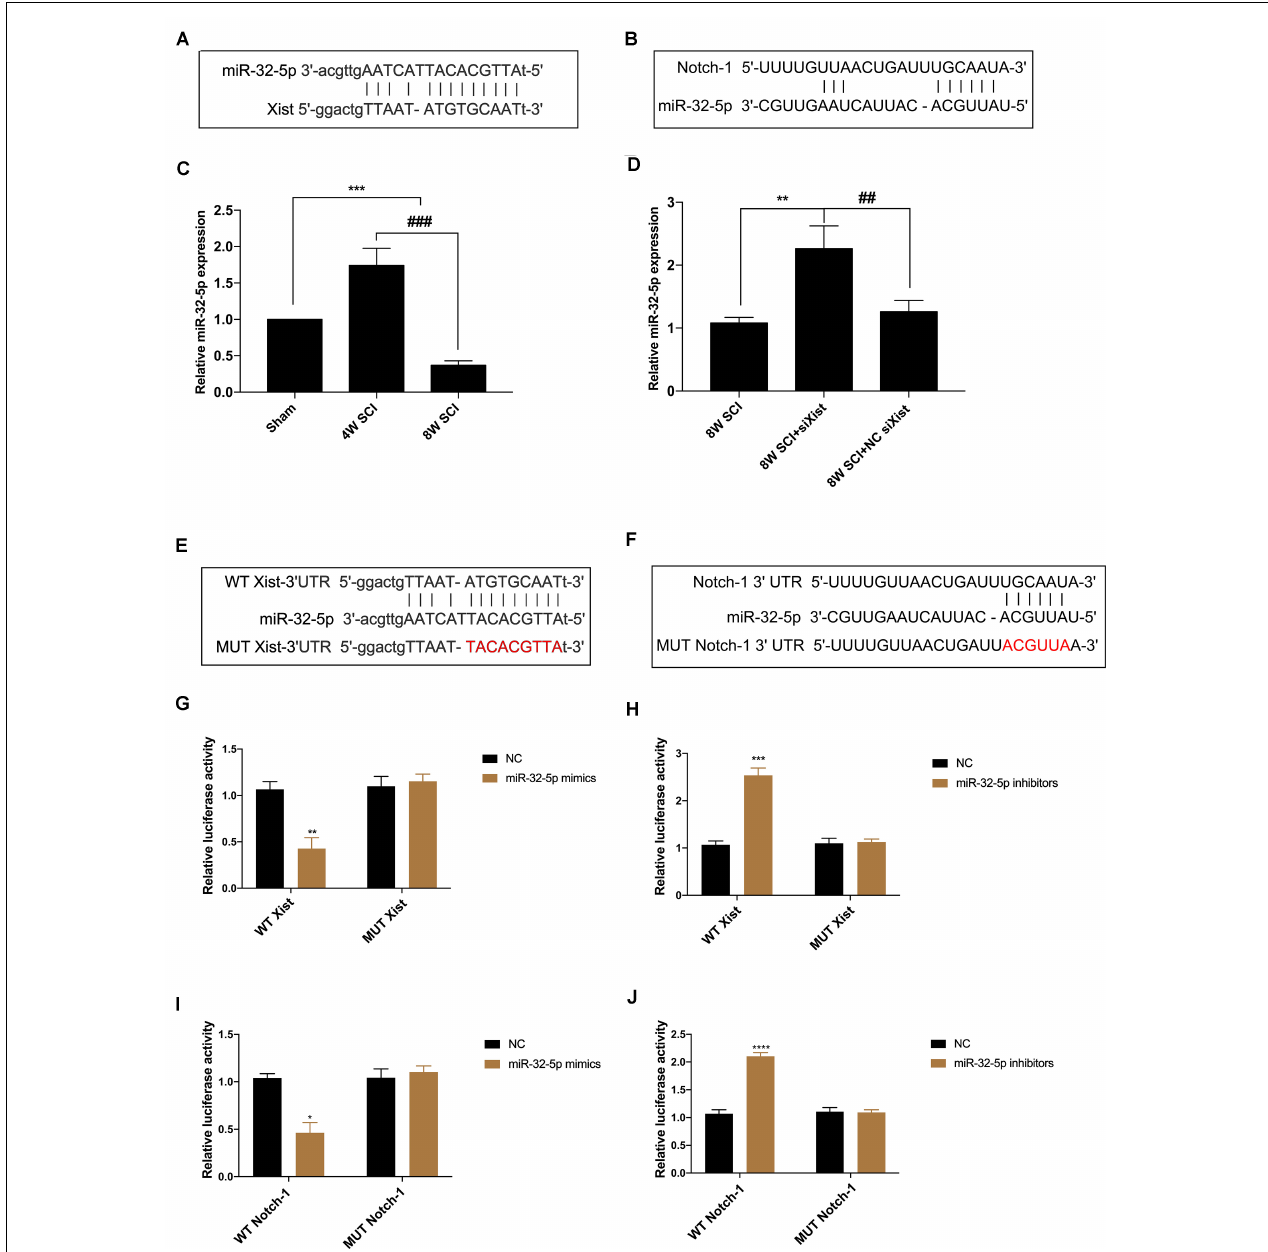
FIGURE 4 | Xist and Notch-1 are direct targets of miR-32-5p. (A) Binding regions between miR-32-5p and Xist. Bioinformatics analysis (ChipBase, LncRNAdb, and StarBase) was used to predict the target microRNA regulated by Xist. (B) Binding regions between Notch-1 and miR-32-5p. Bioinformatics analysis (TargetScan, Starbase, miRanda, and miRDB) was used to predict the putative target of miR-32-5p. (C) Quantitation of the relative miR-32-5p expression in the sham, 4W SCI, and 8W SCI groups by RT-qPCR. (D) Quantitation of the relative miR-32-5p expression in the 8W SCI, 8W SCI + siXist, and 8W SCI + NC siXist groups by RT-qPCR. (E) Dual-luciferase reporter constructs containing the wild-type (WT Xist) or mutant (MUT Xist) Xist sequence. (F) Dual-luciferase reporter constructs containing the wild-type (WT Notch-1) or mutant (MUT Notch-1) Notch-1 sequence. (G) Dual-luciferase reporter assay of miR-32-5p and Xist following transfection of miR-32-5p mimics. HEK-293T cells were co-transfected with the miR-32-5p mimics or corresponding NC and the dual-luciferase vector containing WT Xist or MUT Xist and incubated for 48 h. (H) Dual-luciferase reporter assay of miR-32-5p and Xist following transfection with miR-32-5p inhibitors. HEK-293T cells were co-transfected with the miR-32-5p inhibitors or the corresponding NC and the dual-luciferase vector containing WT Xist or MUT Xist. (I) Dual-luciferase reporter assay of Notch-1 and miR-32-5p following transfection of miR-32-5p mimics. HEK-293T cells were co-transfected with the miR-32-5p mimics or the corresponding NC and the dual-luciferase vector containing WT Notch-1 or MUT Notch-1 and incubated for 48 h. (J) Dual-luciferase reporter assay of miR-32-5p and Xist following transfection with miR-32-5p inhibitors. HEK-293T cells were co-transfected with miR-32-5p inhibitors or the corresponding NC and the dual-luciferase vector containing WT Xist or MUT Xist. Three independent experiments were carried out. * p < 0.05, ** p < 0.01, *** p < 0.001. **** p < 0.0001; ## p < 0.01, ### p < 0.001. Data are expressed as the mean ± SEM.